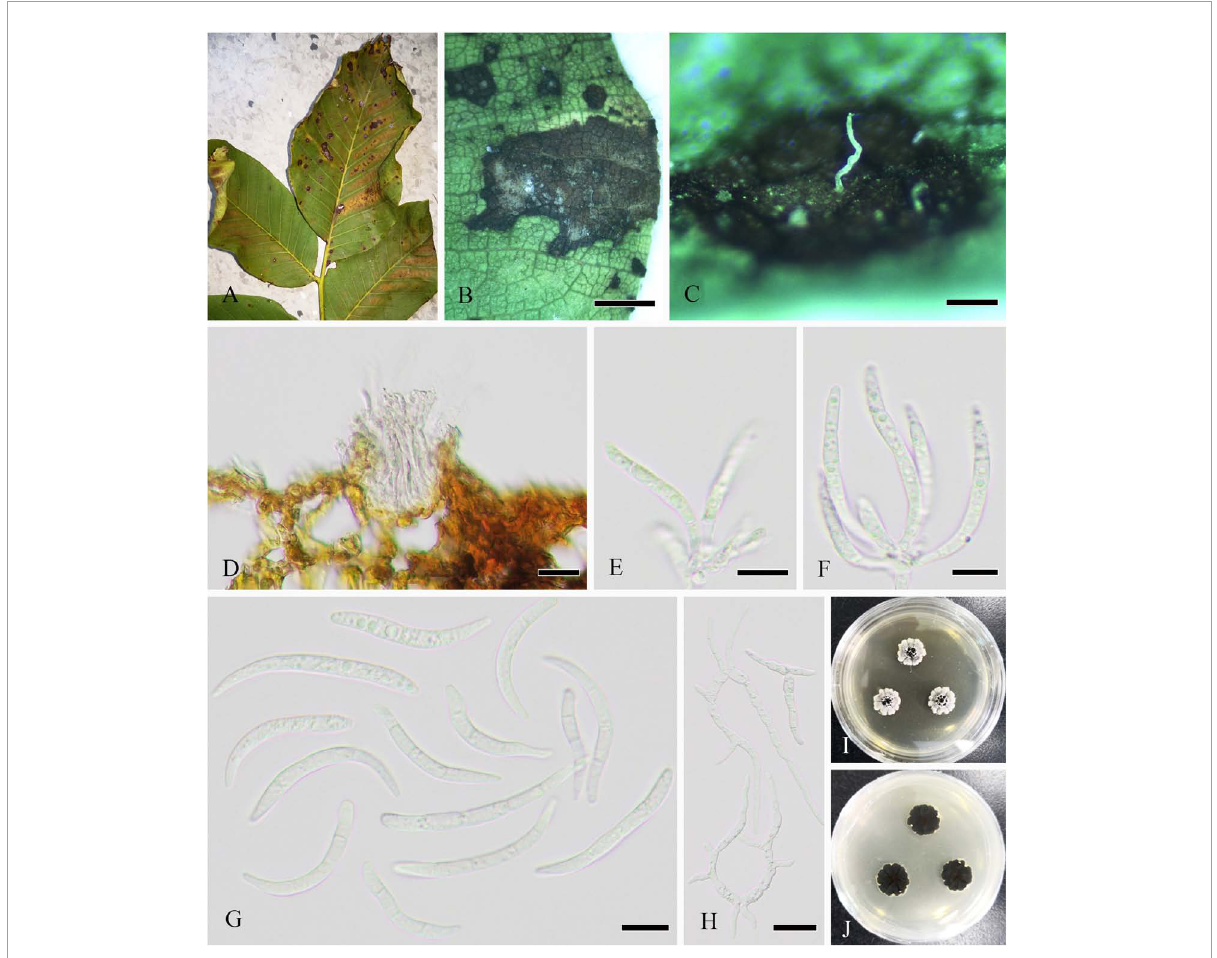
FIGURE11 Sphaerulina juglandina (SICAU 22-0108, holotype). (A,B) Symptoms of leaf spots observed on host. (C) Close-up of conidiomata. (D) Section though conidioma. (E,F) Conidiogenous cells and conidia. (G) Conidia. (H) Germinating conidia. (I,J) Colonies on PDA for 15 days. Scale